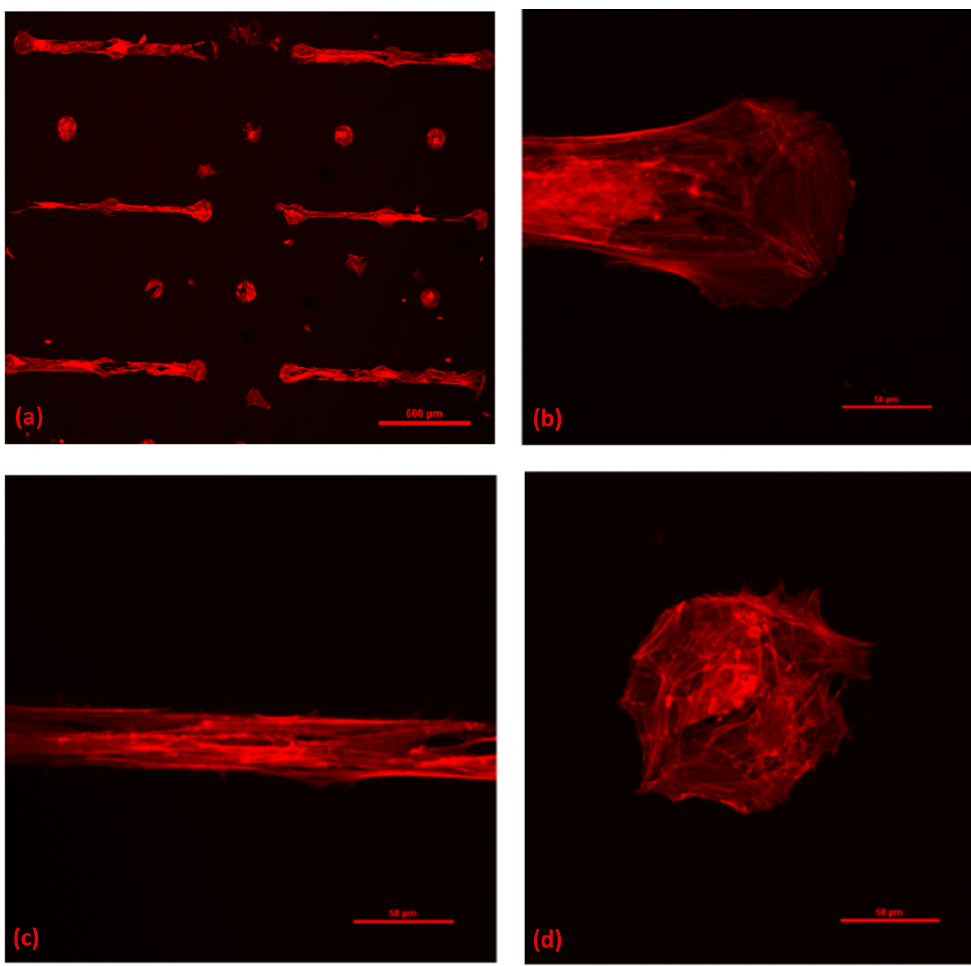
Figure 5. Fluorescence images of actin cytoskeletons of astrocytes confined on patterned nanostruc- tured zirconia with bridges 20 and 50 μ m large and dots 100 μ m large in diameter ( a ), details of 50- μ m-large bridge ( b ), 20- μ m-large bridge ( c ) and 100 μ m dot ( d ).